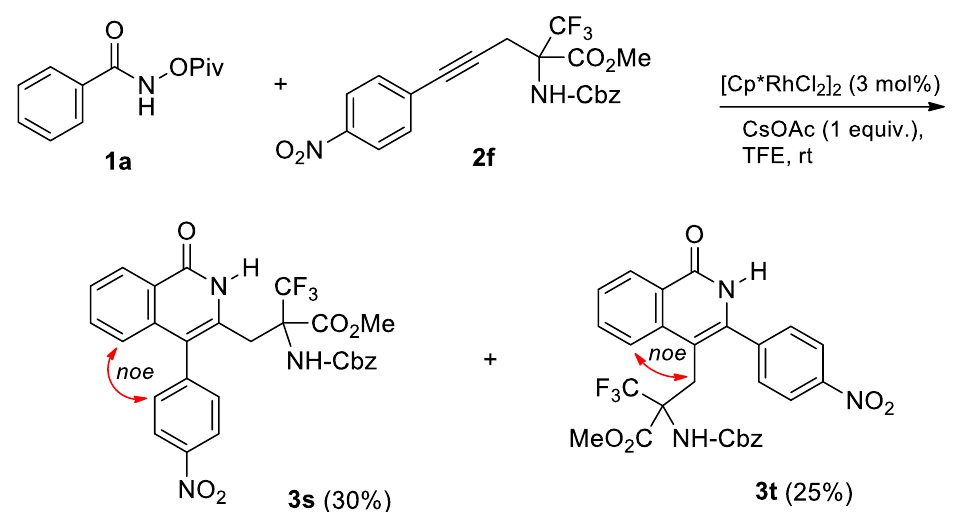
Scheme 3. Reaction of 1a with para-nitrophenyl acetylene 2f .